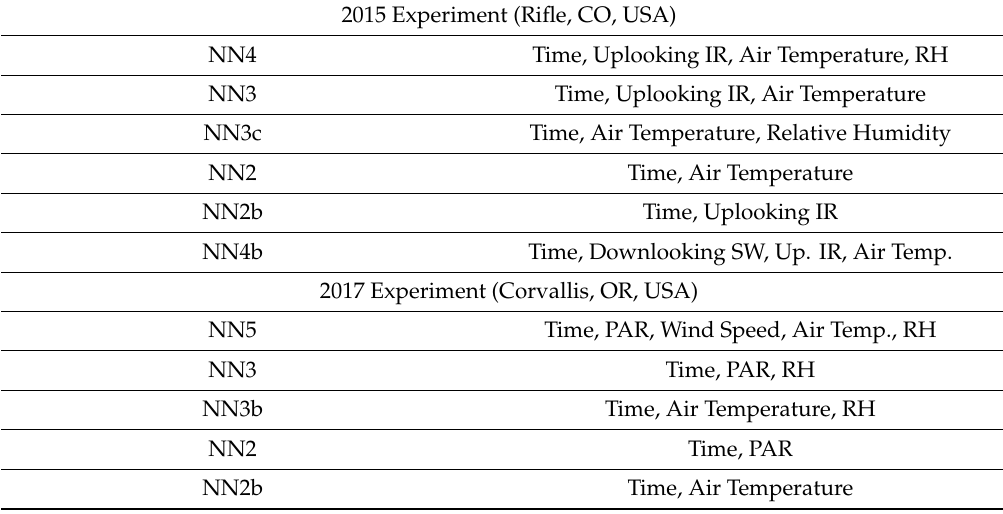
Table 3. Data type designations: Time = Recorded time of day; IR = Pyrgeometer; RH = relative humidity; SW = Pyranometer; PAR = Photosynthetic Active Radiation (flux); “Downlooking” indicates a sensor pointing toward the ground; “Uplooking” indicates skyward-pointing